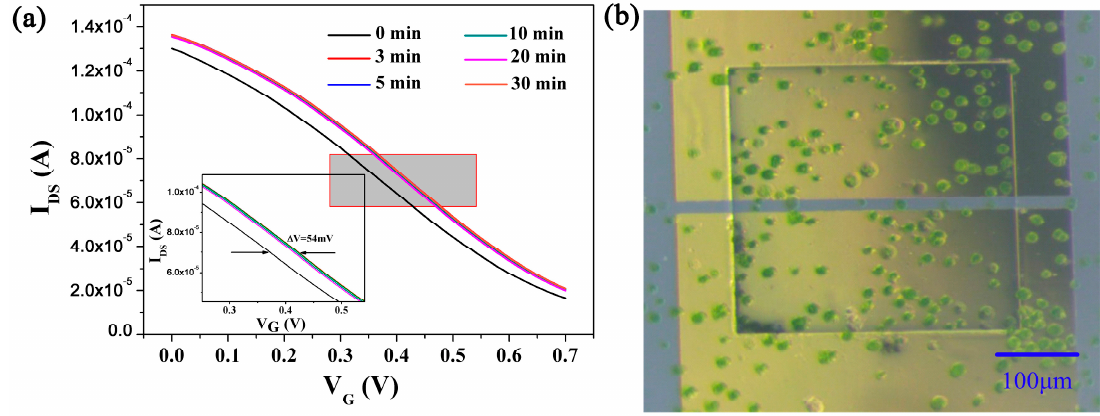
Figure 3. ( a ) I DS vs V G (transfer characteristics) of an OECT measured in the culture medium before (0 min) and at 3, 5, 10, 20 and 30 min after loading the green cyst H. pluvialis cells, V DS = 0.1 V; ( b ) Optical image of the green cyst H. pluvialis cells precipitated on the OECT channel film in the SU-8 microwell.